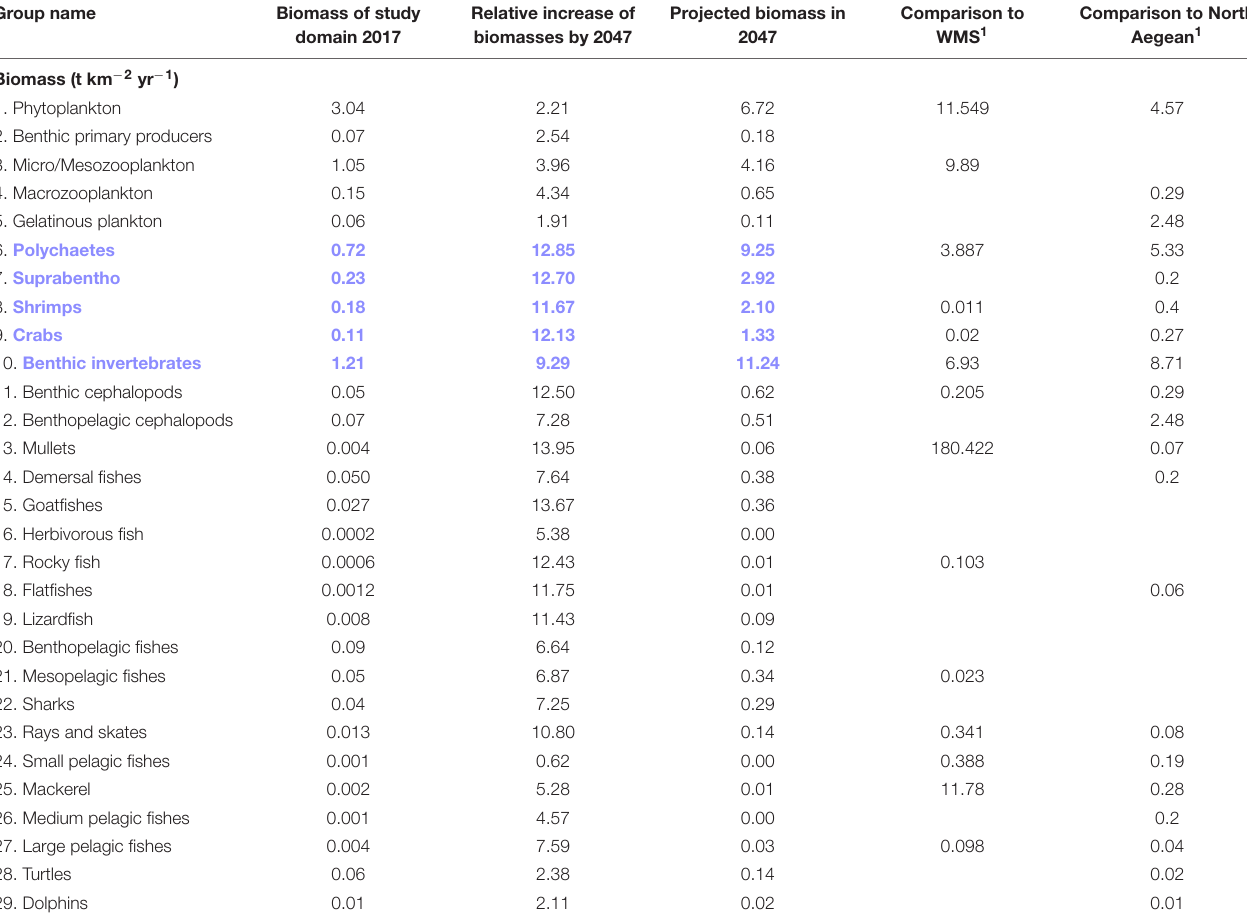
TABLE 2 | Relative biomass increases of all functional groups over 30-year period (from 1000 t farm production to 21,000